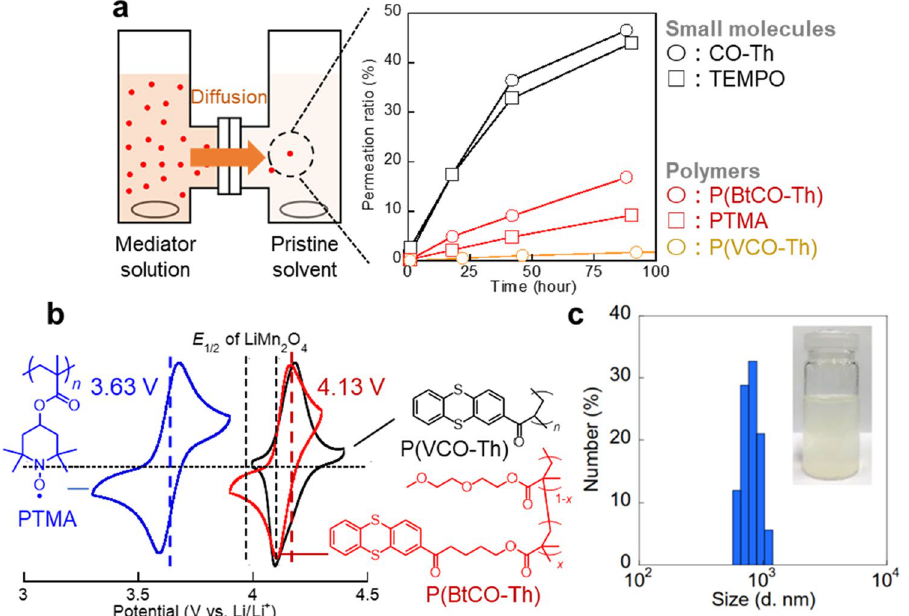
Figure 3. ( a ) Configuration of the cell for permeation test and related experimental result. The mediators were dissolved or dispersed in the carbonate solvent and kept stirred to proceed with permeation to the other cell with only solvents. UV–Vis measurements estimated the permeation amount. ( b ) Cyclic voltammograms of the three polymers. Soluble PTMA and P(BtCO-Th) were dissolved at a concentration of 5 mM and scanned at 50 mV/s. A carbon composite electrode was prepared for insoluble P(VCO-Th) and scanned at 50 mV/s. c, Dynamic light scattering spectrum for P(VCO-Th) dispersed at a concentration of 1 mM in the carbonate